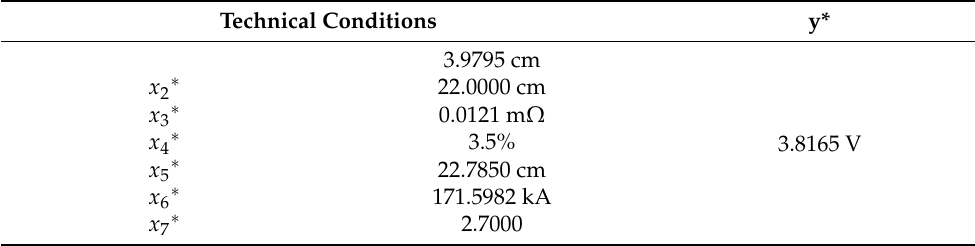
Table 6. Results of the cell voltage optimization.